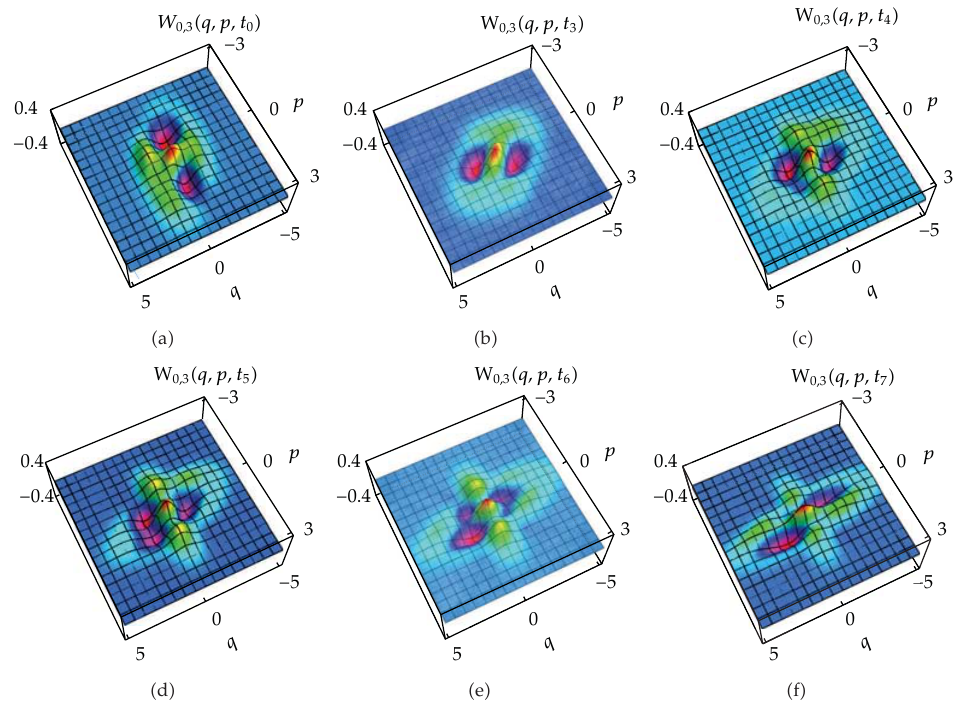
√ 2 (cid:5)(cid:4) | 0 (cid:4) (cid:9) | 3 (cid:4) (cid:5) at successive times; δ 0 (cid:8) 0 .